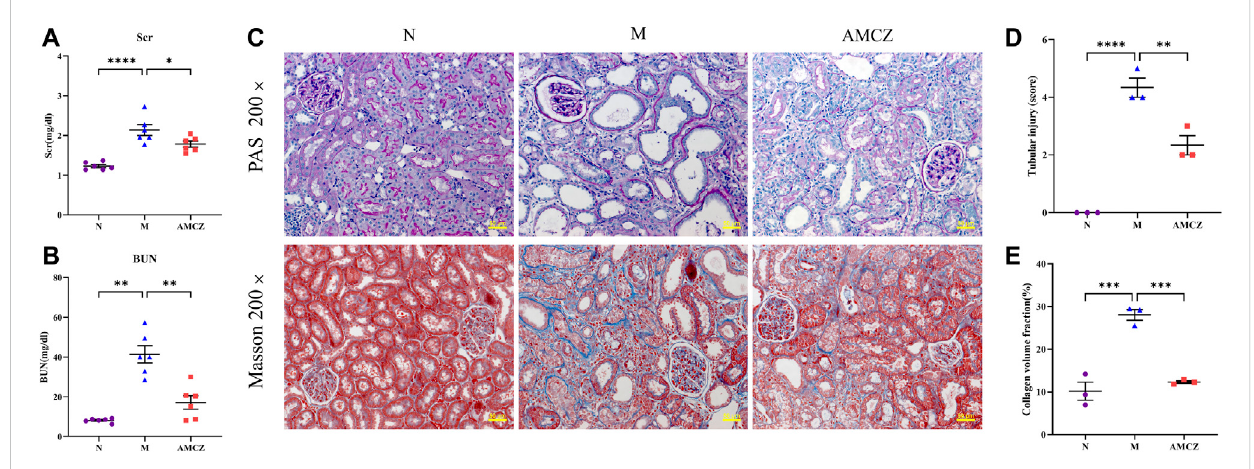
FIGURE 1 Effects of AM and CZ in the CKD rats. (A) The level of Scr (n = 6). (B) The level of BUN (n = 6). (C) PAS staining and Masson staining of kidney. (D) Quantitative analysis of renal tubular injury score in all groups. (E) Quanti fi cation of collagen volume fraction (collagen area/total area × 100%) in all groups. Data are presented as the means ± SEM (**** p < 0.0001, *** p < 0.001, ** p < 0.01, * p <